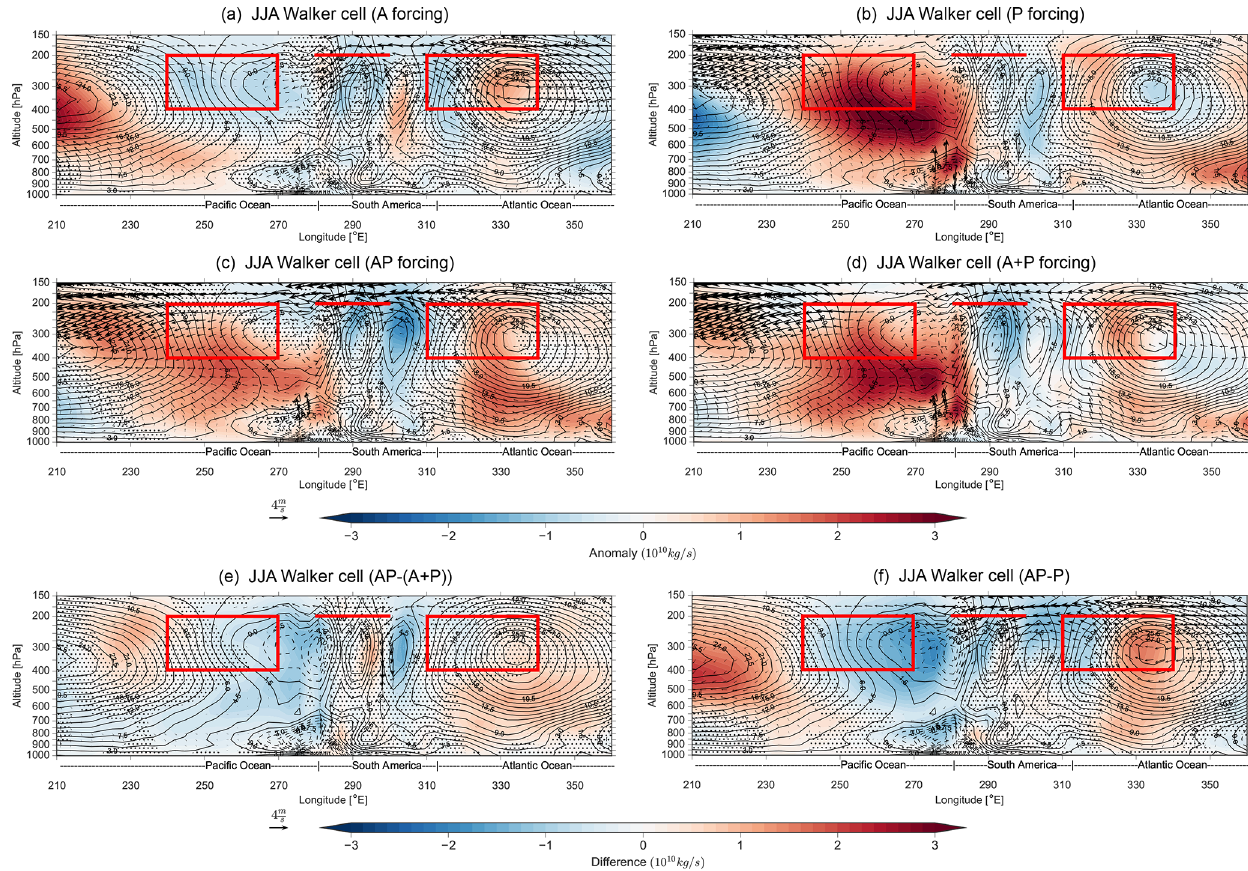
Figure 5. Same as Fig. 4 but for